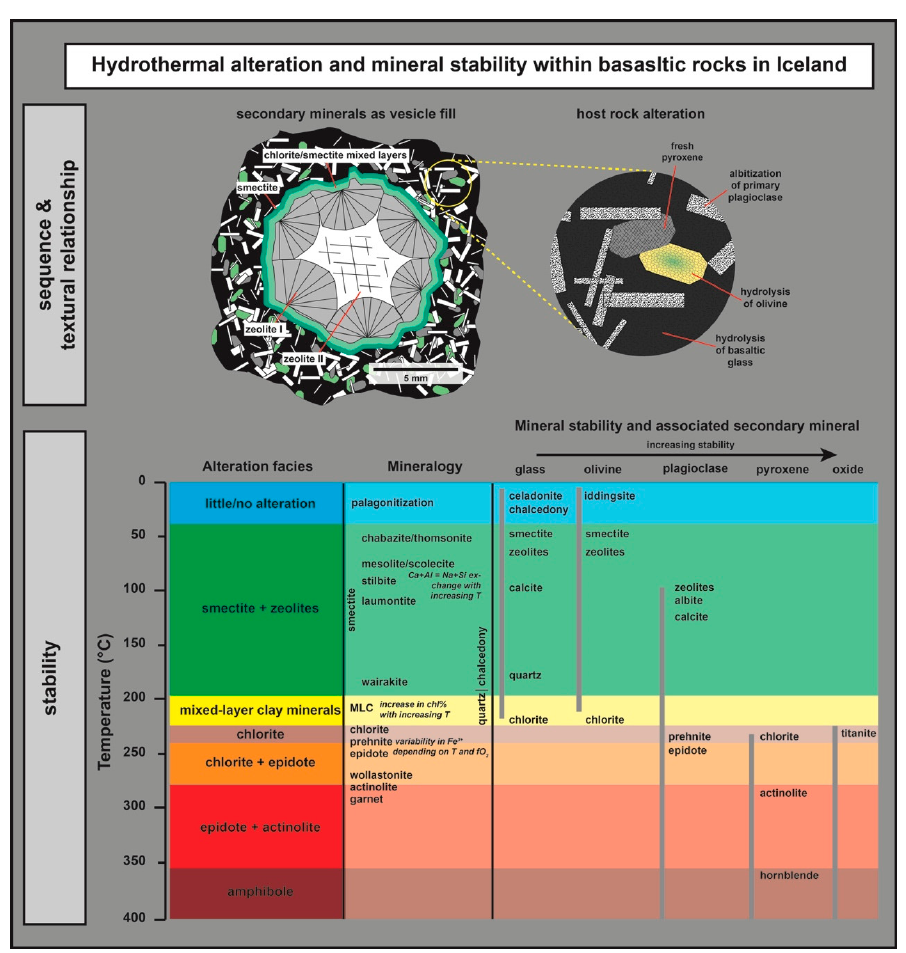
Figure 2. Stability fields of secondary minerals, including chemical vectors, primary minerals and their alteration product for basaltic rocks in Iceland. The sketch in the upper part shows a prograde mineral sequence as observed in Iceland geothermal system at low-temperature conditions (modified after Kousehlar et al.